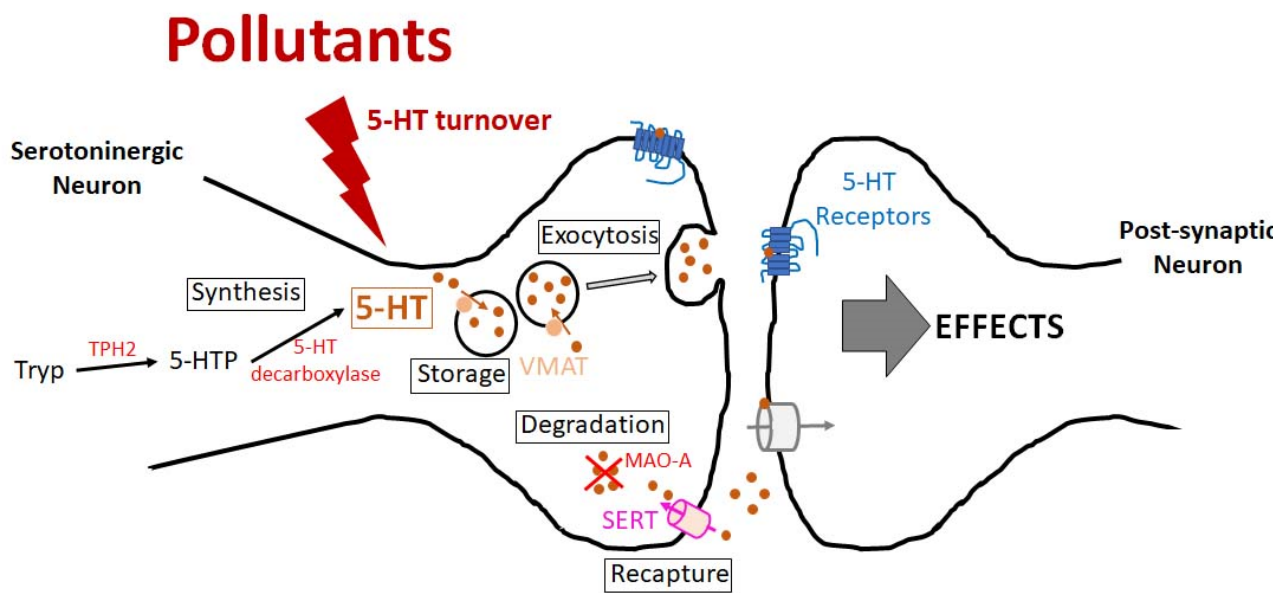
Figure 1. Effects of environmental chemical pollutants on the serotoninergic system. This figure summarizes the potential action of chemical pollutants on serotonin turnover. Other reported actions are on the expression of serotonin transporter genes and on the expression of serotonin receptor subtypes. See text for details. 5-HT: 5-hydroxytryptamine, serotonin; 5-HTP: 5-hydroxytryptophan; MAO-A: monoamine oxidase-A; SERT: serotonin transporter; Tryp: tryptophan; TPH2: tryptophan hydroxylase; VMAT: vesicular monoamine transporter.